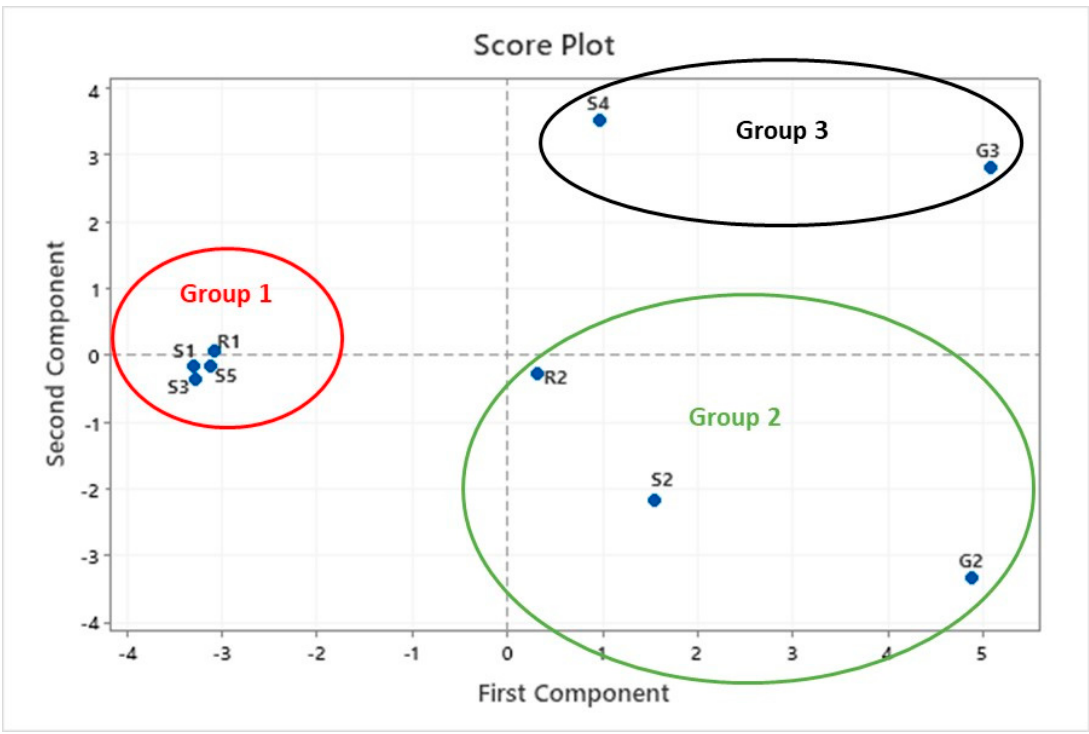
Figure 6. Score Plot of PCA analysis applied to 9 sampling stations of Koiliaris CZO. The analysis highlighted 3 groups describing the geochemistry of the area.